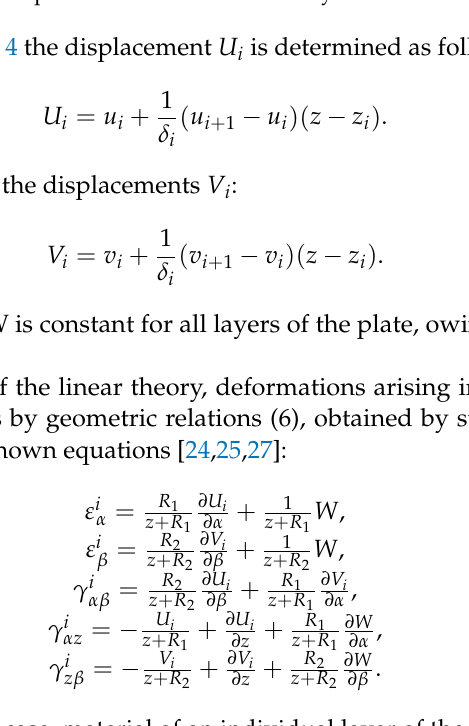
Figure 4. Approximation of displacements within the i–th